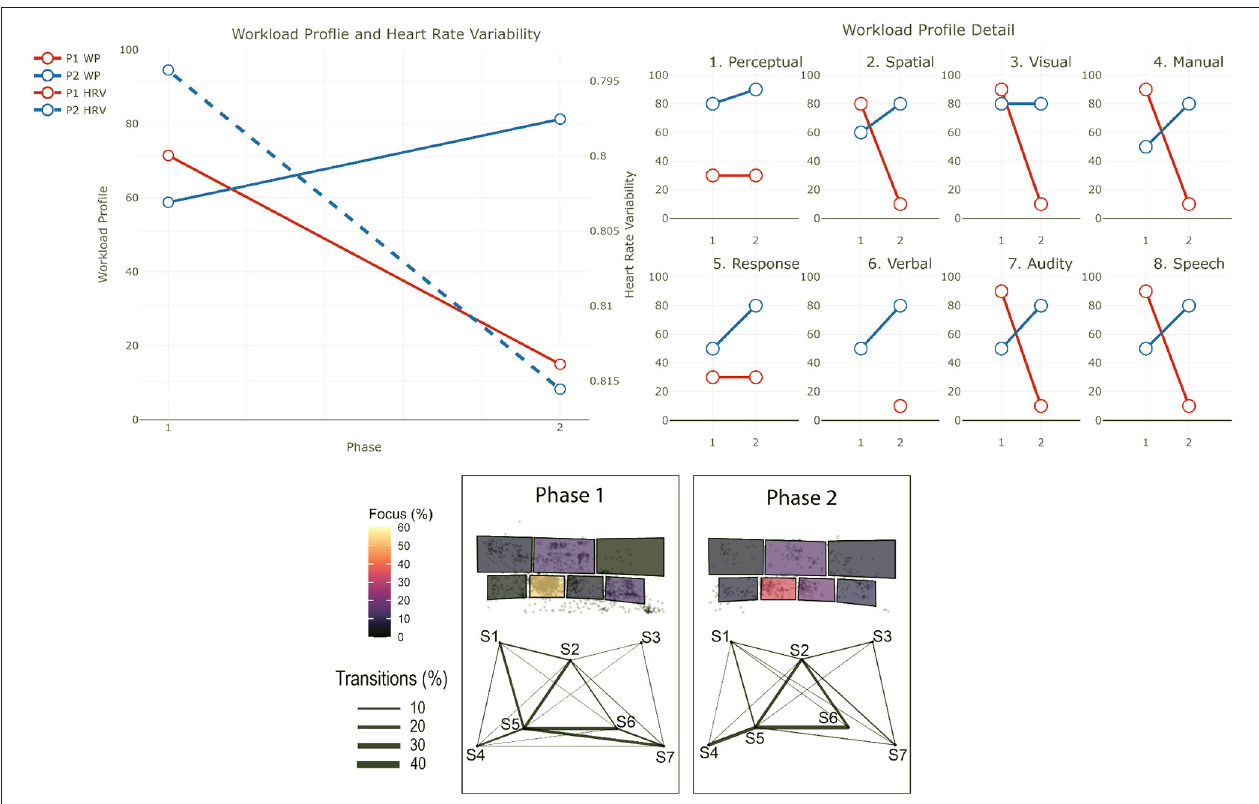
FIGURE 5 | Results for training 2. The top-left chart shows the evolution of the WP and HRV during the session for both participants (the axis of the HRV is inverted). The top-right chart shows the evolution of each criteria of the WP during the session for both participants. The bottom chart displays eye tracking data for P2 for each phase: at the top is the schematic representation of the operator’s workspace with a heatmap showing the amount of time the operator spent focusing on each screen; the bottom graph indicates the amount of transition between each of the screens with the thickness of the lines. The same organization is used in the following